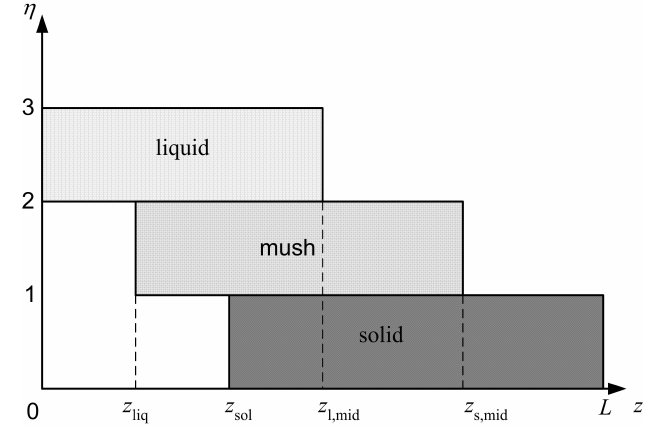
Figure 5. Computational domain in ( η , z )